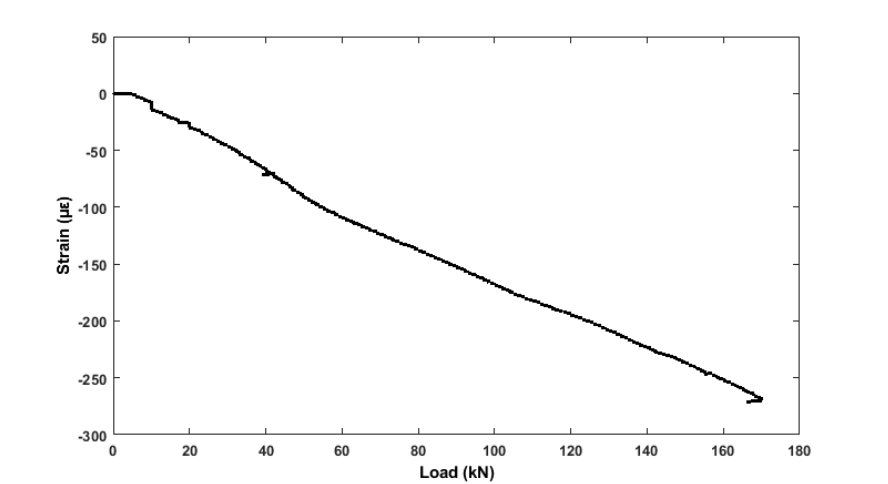
Figure 18. Strain (attached with top rebar) vs.